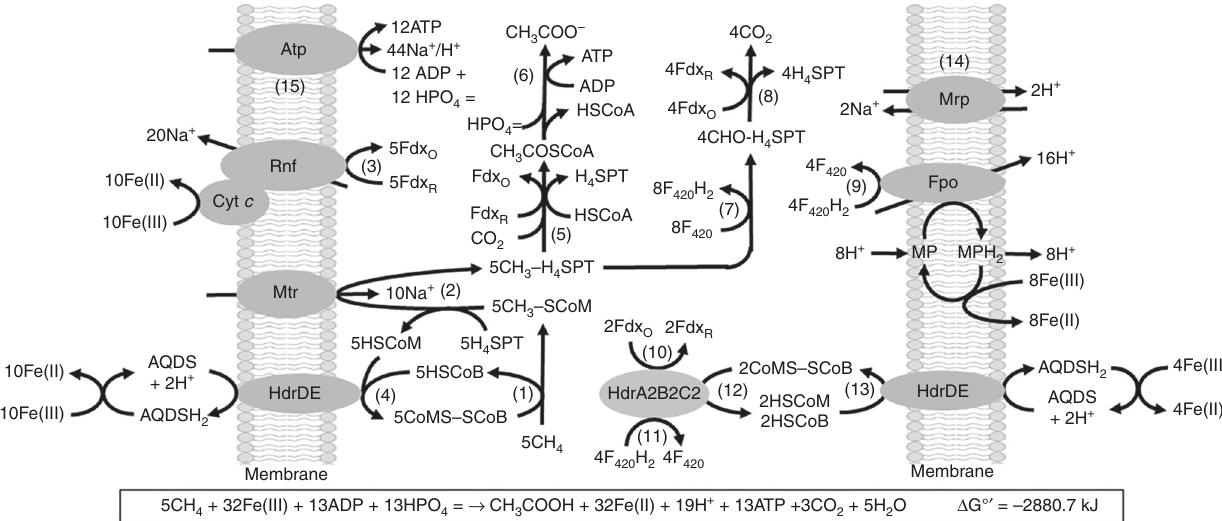
Fig. 5 Pathway proposed for Fe(III)-dependent methane oxidation and conservation of energy by M. acetivorans . Enzymes not discussed in the text: CO dehydrogenase/acetyl-CoA synthase (Rxn. 5); acetate kinase and phosphotransacetylase (Rxn. 6); coenzyme F 420 (F 420 )-dependent methylene- tetrahydrosarcinapterin (H 4 SPT) reductase, F 420 -dependent methylene-H 4 SPT dehydrogenase, methenyl-H 4 SPT cyclohydrolase, and formylmethanofuran: H 4 SPT formyltransferase (Rxn. 7); formylmethanofuran dehydrogenase (Rxn. 8). MP,